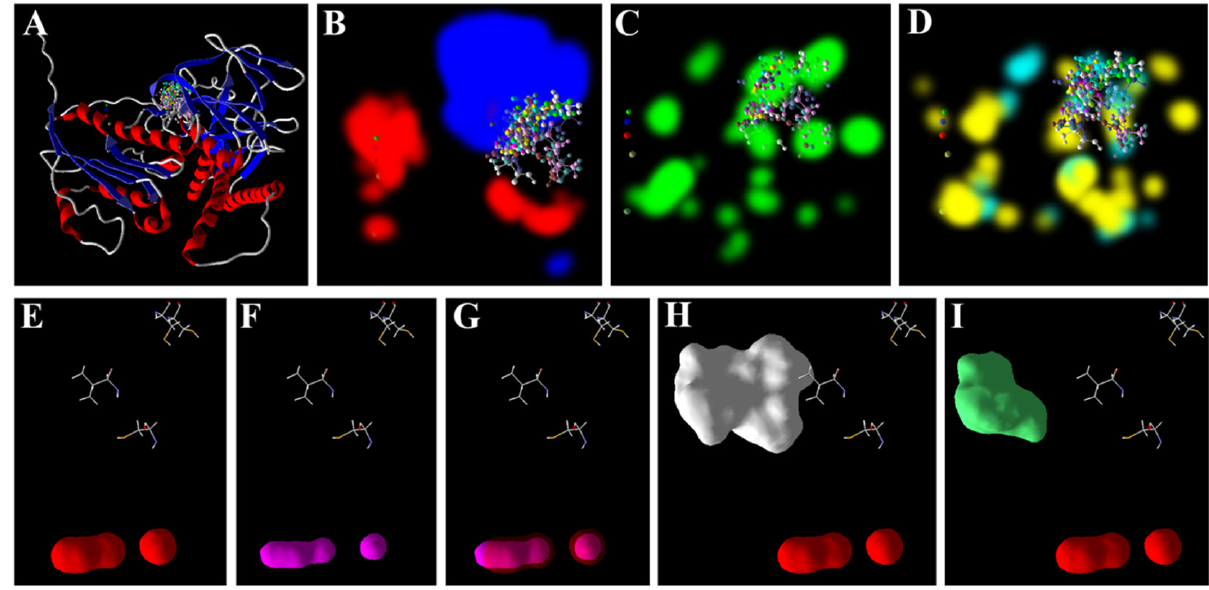
Figure 3. Docking poses and interactions of GR of rice with ligands: ( A ) poses of all ligands; regions of the receptor along with docked ligands favoring ( B ) electrostatic, ( C ) stearic and ( D ) hydrogen bond interactions. van der Waals surfaces of ( E ) As 3+ , ( F ) Zn 2+ , and overlapped surfaces of ( G ) As 3+ and Zn 2+ . It may be noted that the surfaces of AsA ( H ) and GSH ( I ) do not show any overlapping with that of As 3+ . Poses and surfaces were developed using MVD.